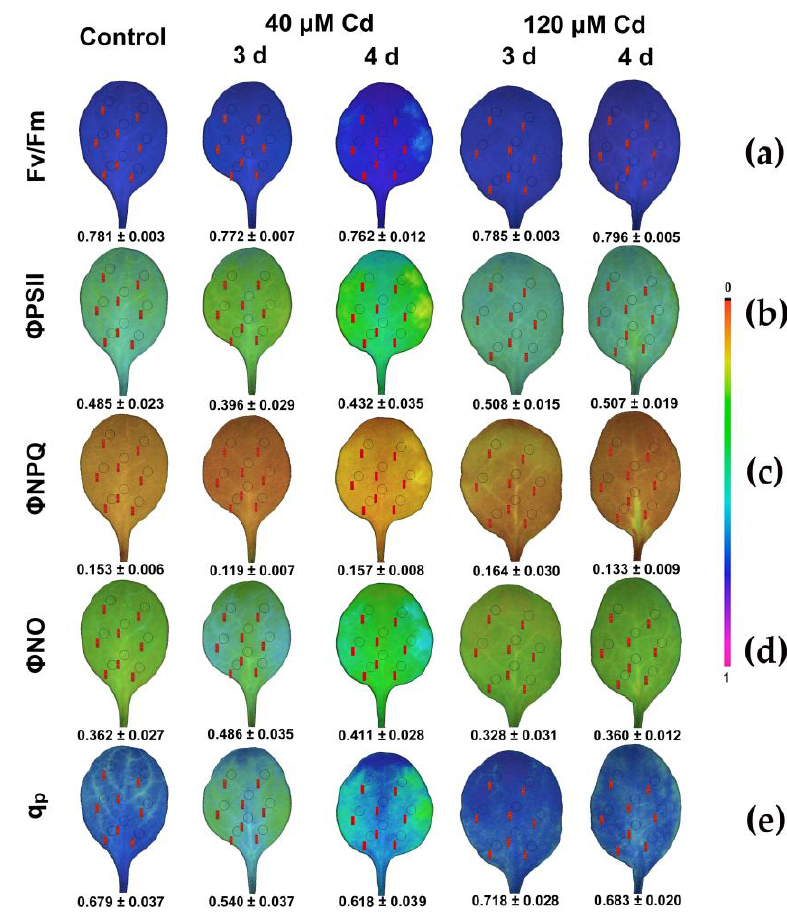
Figure 8. Representative chlorophyll fluorescence images of the maximum quantum efficiency ( F v / F m ) of PSII after 15 min dark adaptation ( a ) and after 5 min illumination at 300 µ mol photons m − 2 s − 1 actinic light; of the actual (effective) quantum yield of PSII photochemistry ( Φ PSII ) ( b ), the quantum yield for dissipation by downregulation in PSII ( Φ NPQ ) ( c ), the quantum yield of non-regulated energy loss in PSII ( Φ NO ) ( d ), and the relative reduction state of Q A , reflecting the fraction of open PSII reaction centers ( q P ) ( e ). N. caerulescens plants were grown at 0 (control), 40 or 120 µ M Cd 2+ for 3 and 4 days. The colour code depicted at the right side of the images ranges from black (pixel values 0.0) to purple (1.0). The eight areas of interest are shown in each image. The average value of each photosynthetic parameter of the leaf is presented in the figure.